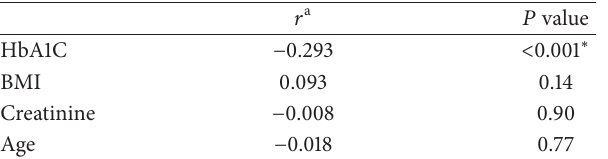
Table 3: Relationship between serum albumin concentration and clinical